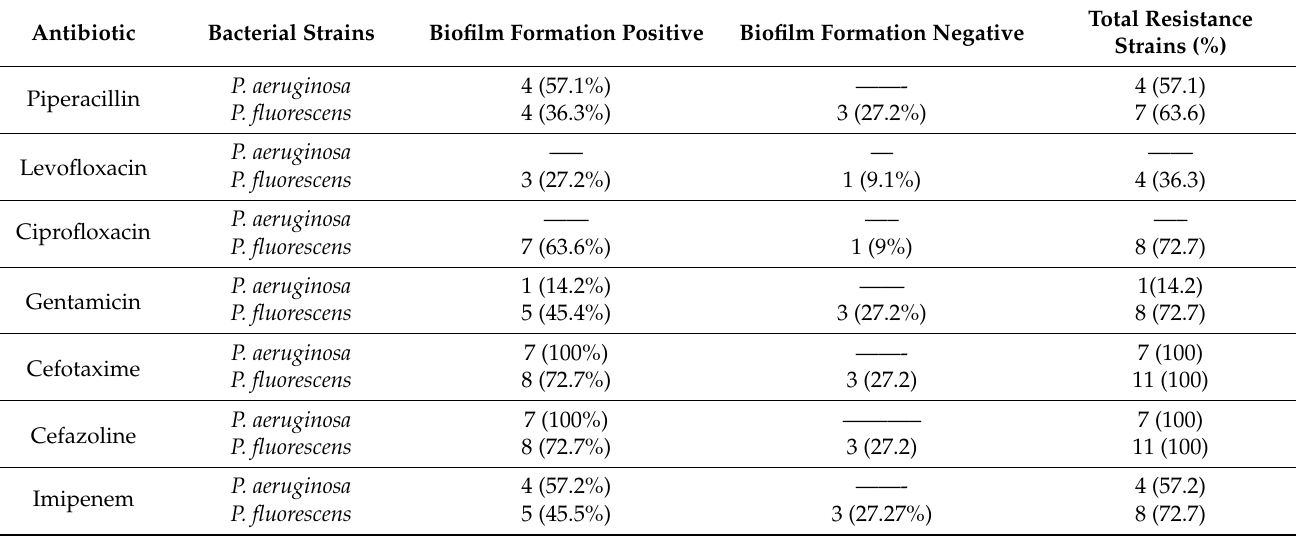
Table 3. Antibiotic resistance and biofilm formation results of Pseudomonas